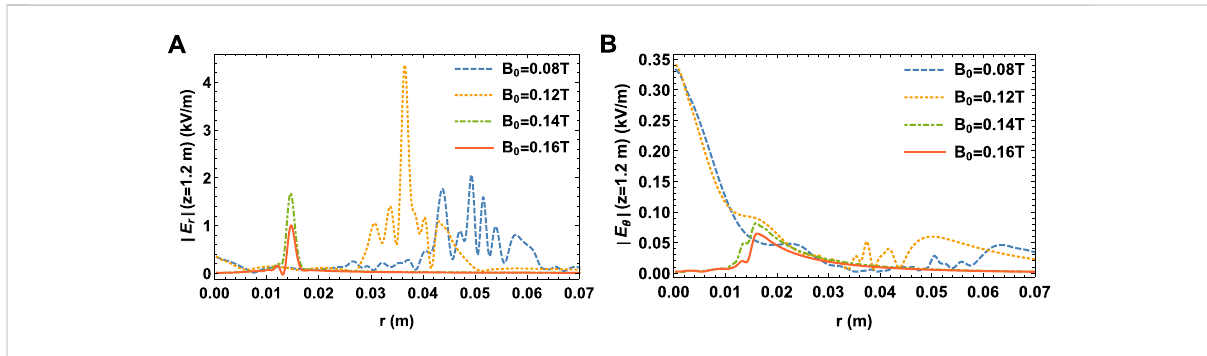
FIGURE 3 Radialpro fi lesofwaveelectric fi eld (A) ,radialcomponent; (B) ,azimuthalcomponentforfourexternalmagnetic fi eldstrengths,measuredat z = 1.2 m ( P 1 ).